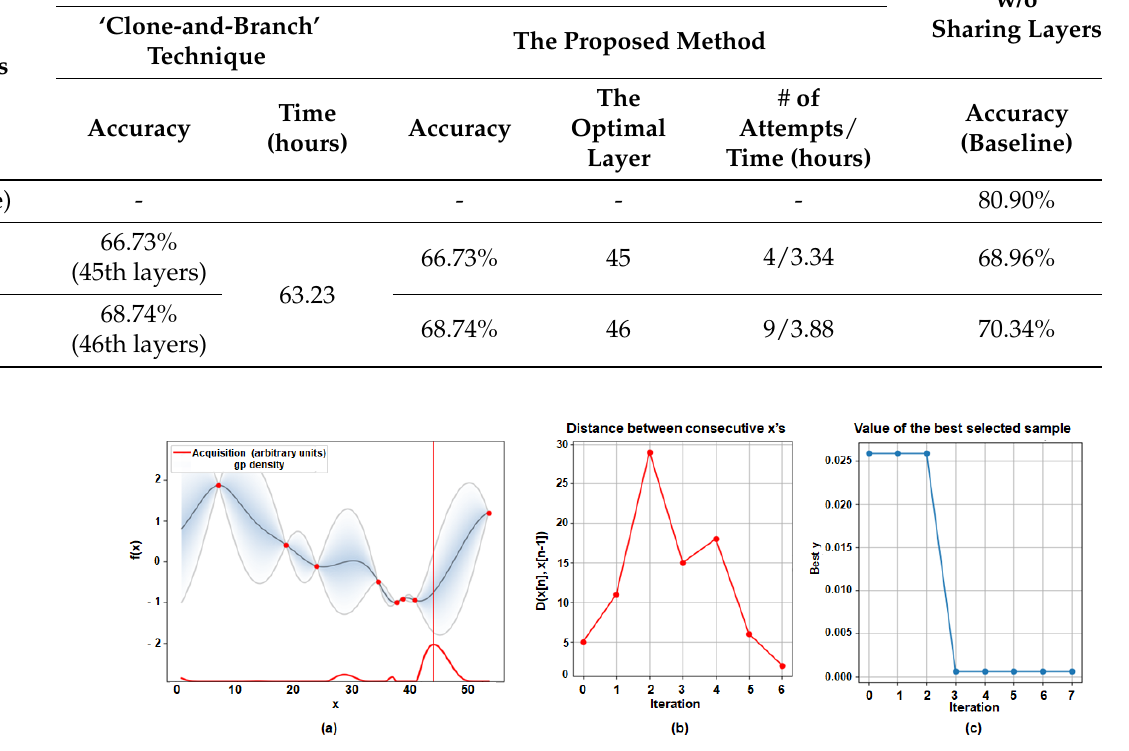
Figure 9. Visualization results of the optimal sharing layer configuration through BayesOpt BayesOpt as threshold accuracy degradation is 8% less than the baseline accuracy. (EMNIST: 40 classes/seven classes) ( a ) the result of the selected optimal number of sharing layers. ( b ) The L2 distance of the consecutive observed points. ( c ) The value of the calculated best-selected sample for every